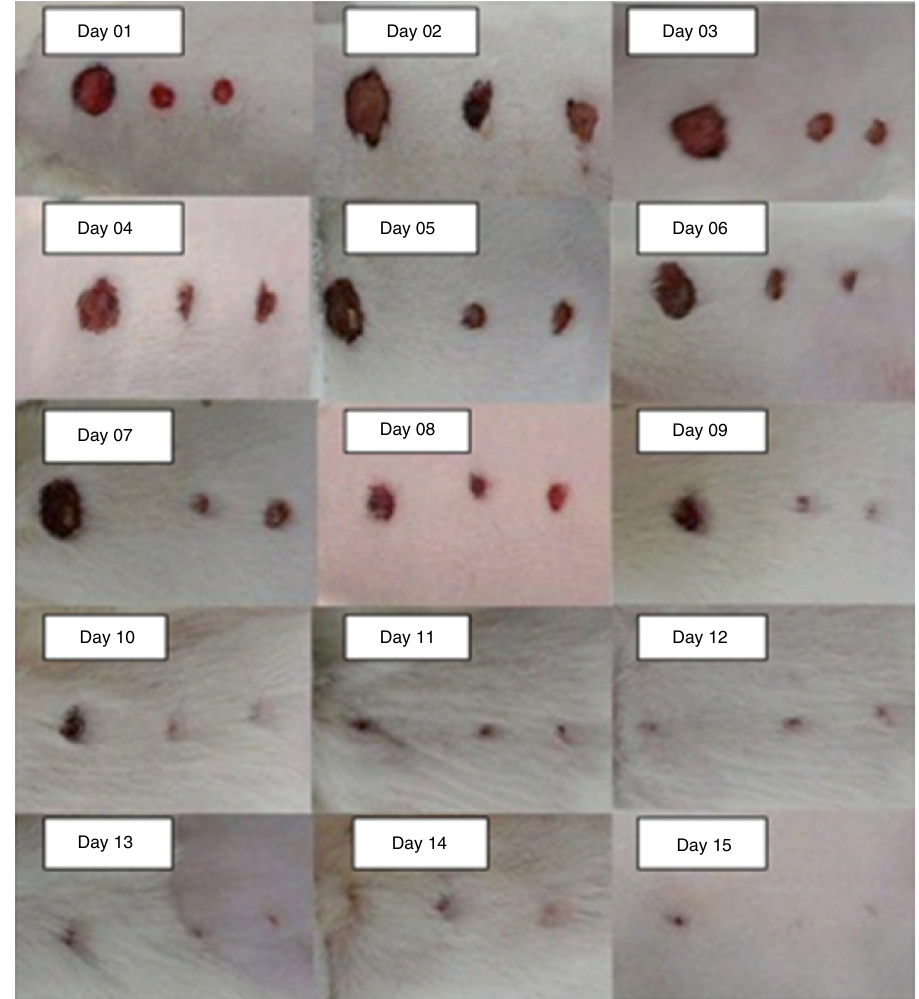
Figure 3 Pictures of wounds from the first to the 15th day of the experiment, taken of different